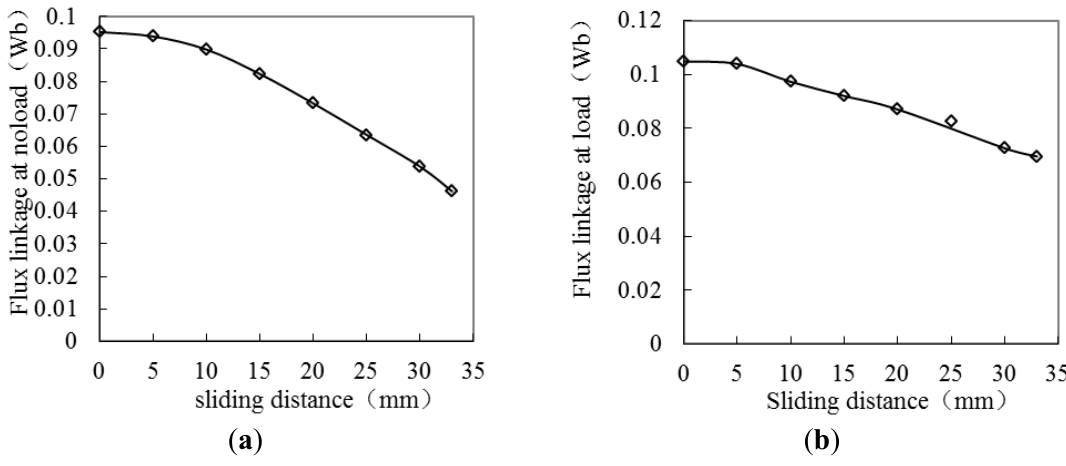
Figure 13. Changing law of flux linkage with the PMs sliding distance: ( a ) ψ ( b ) ψ at load